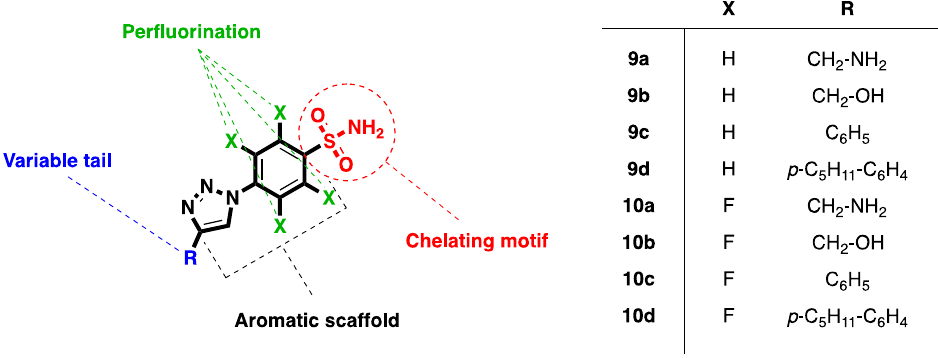
Figure 3. General structure of compounds 9a – d and 10a – d .